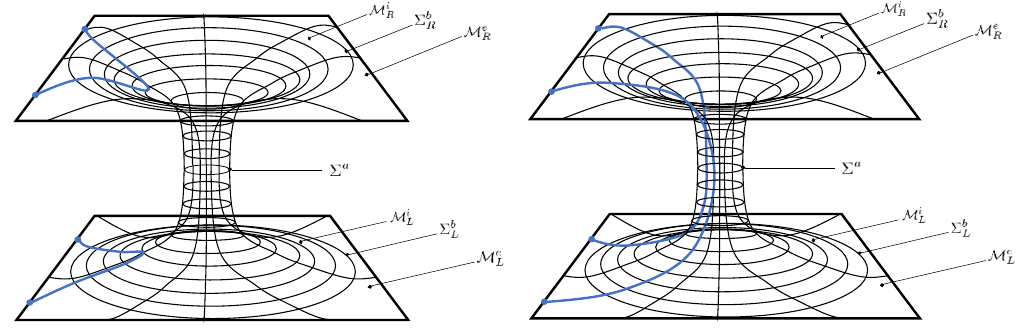
Figure 1 . Sketch of the wormhole geometry and strings probing